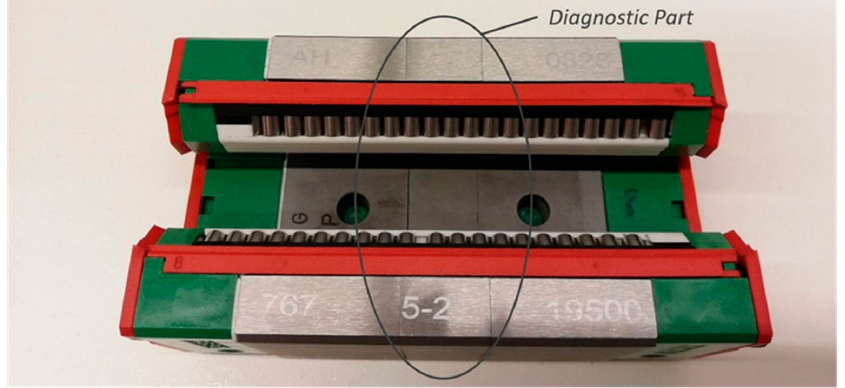
Figure 6. The functional sample.